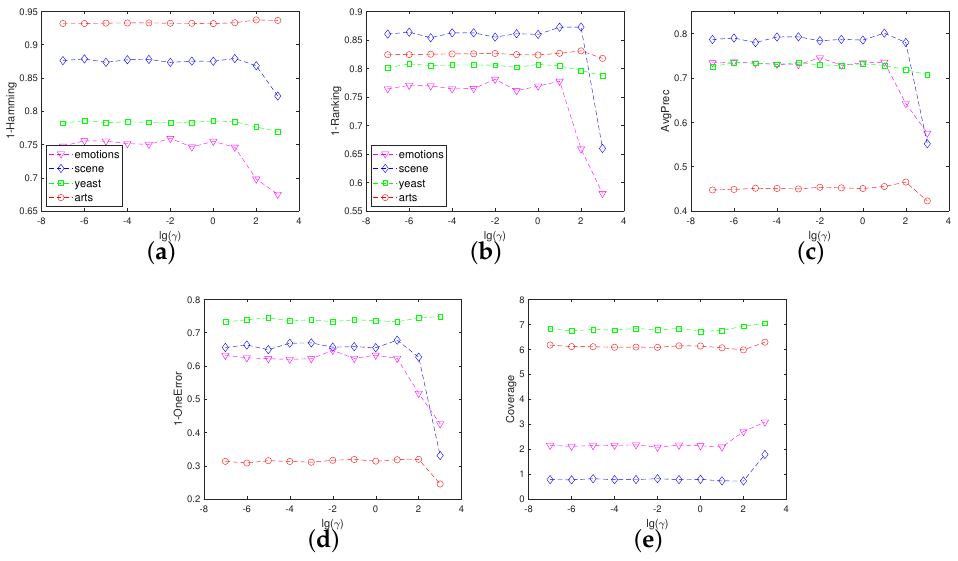
Figure 9. Sensitivity analysis of parameter γ on four data sets for five evaluation metrics. ( a ) 1-Hamming. ( b ) 1-Ranking. ( c ) AvgPrec. ( d ) 1-OneError. ( e )